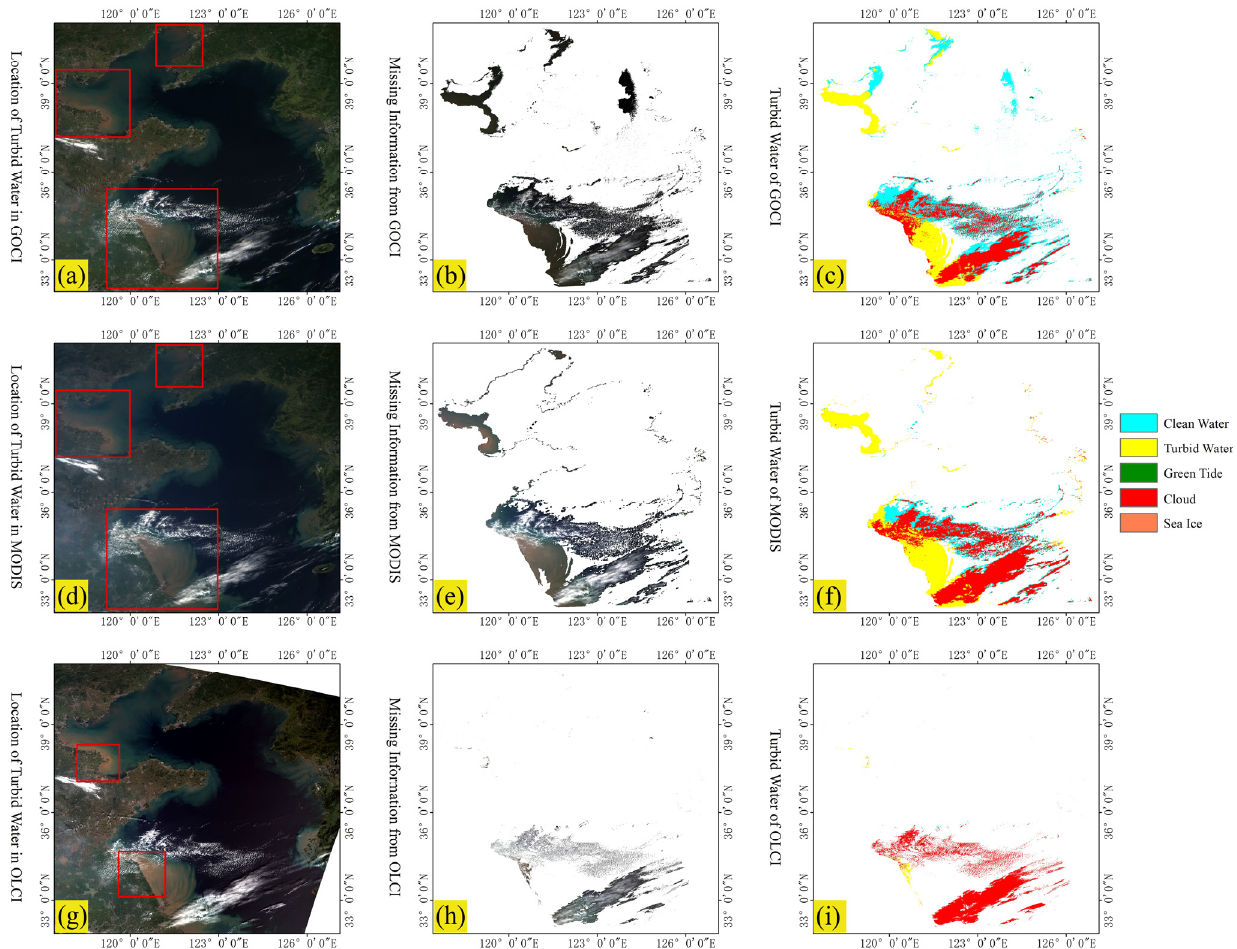
Figure 17. Schematic diagram of turbid water in the data-free areas: ( a , d , g ) the true color images at the spatial locations of the turbid water for GOCI, MODIS and OLCI data, respectively; ( b , e , h ) the condition of the data-free area; ( c , f,i ) the identifi-cation status of the marine objects in the data-free area. The red boxes in ( a , d , g ) represent the main turbid water areas.